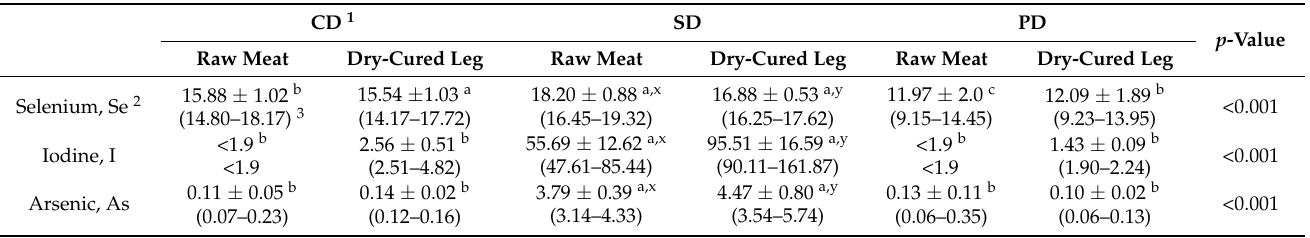
Table 3. Micronutrient content in raw meat and dry-cured leg from lamb fed three finishing diets. Results are presented as mean ± STD ( n =